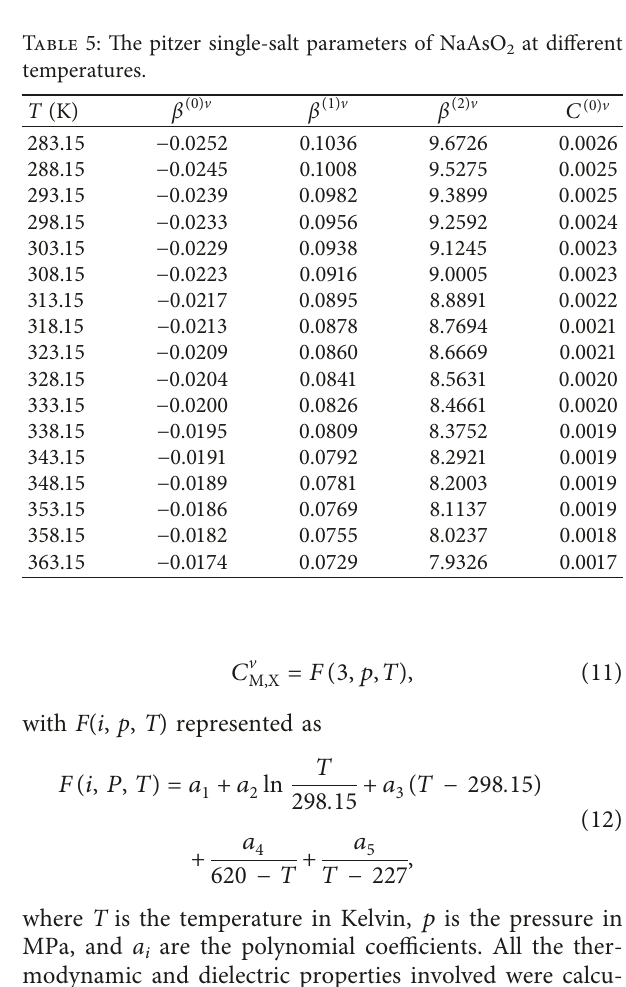
2 aqueous solution